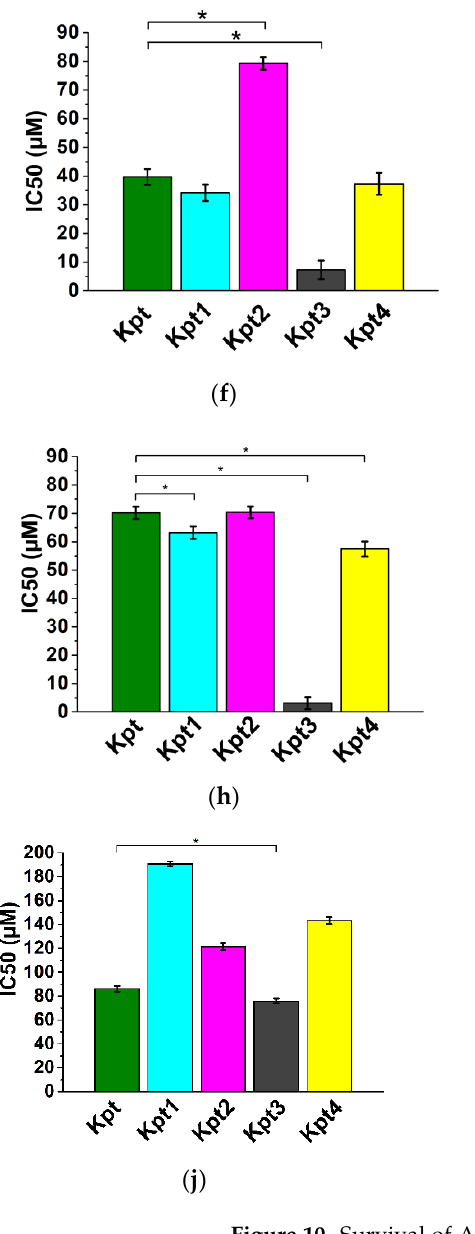
Figure 10. Survival of A549 cells after incubation during 72 h with: ( a ) Kpt and Kpt-NP; ( b ) Kpt1 and Kpt1-NP; ( c ) Kpt2 and Kpt2-NP; ( d ) Kpt3 and Kpt3-NP; ( e ) Kpt4 and Kpt4-NP. IC 50 values of Kpts and NPs: difference among substances against ( f ) A549 cells, ( h ) H69 cells, ( j ) MCF-7 cells; comparison of Kpts/NPs pairs against ( g ) A549 cells, ( i ) H69 cells, ( k ) MCF-7 cells. Each point shows mean ± SD ( n = 3); * p < 0.05.